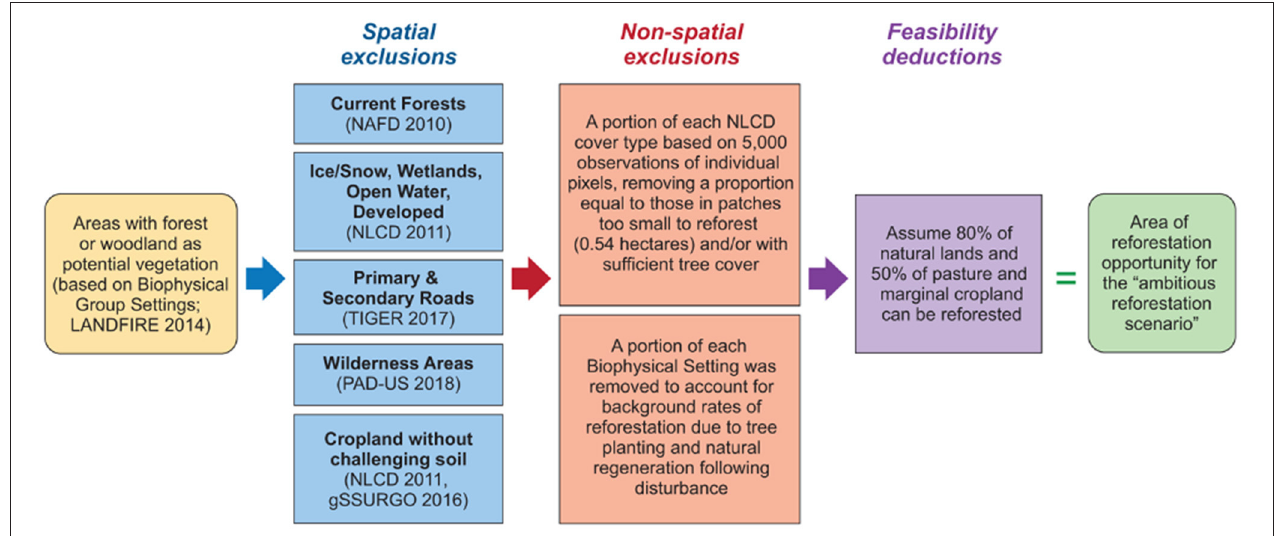
FIGURE 3 | Using data from Cook-Patton et al. (2020), we used these criteria to quantify reforestation opportunities in the US. Datasets are referenced in parentheses where the year indicates the vintage of the data. Citations for these datasets are: LANDFIRE: (U. S. Department of the Interior Geological Survey, 2014); NAFD: ( Goward et al., 2016); National Land Cover Dataset 2011: (Homer et al., 2015); TIGER: (US Census Bureau, 2017); Protected Area Database of the US (PAD-US): (U. S. Geological Survey Gap Analysis Project et al., 2018); gSSURGO: (Soil Survey Staff,